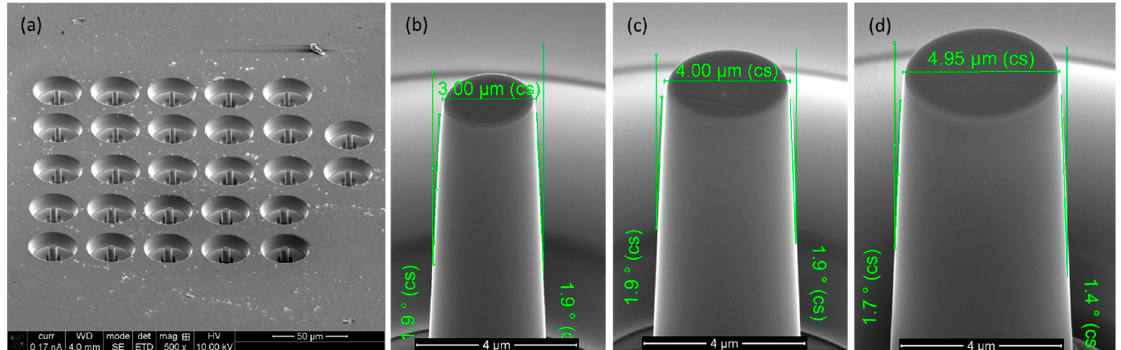
Figure 2. A 52° view of ( a ) an array of micro-pillars and detailed morphology of each type of micro-pillars: ( b ) Ø 3 µm, ( c ) Ø 4 µm and ( d ) Ø 5 µm. ( c ) Ø 4 µ m and ( d ) Ø 5 µ